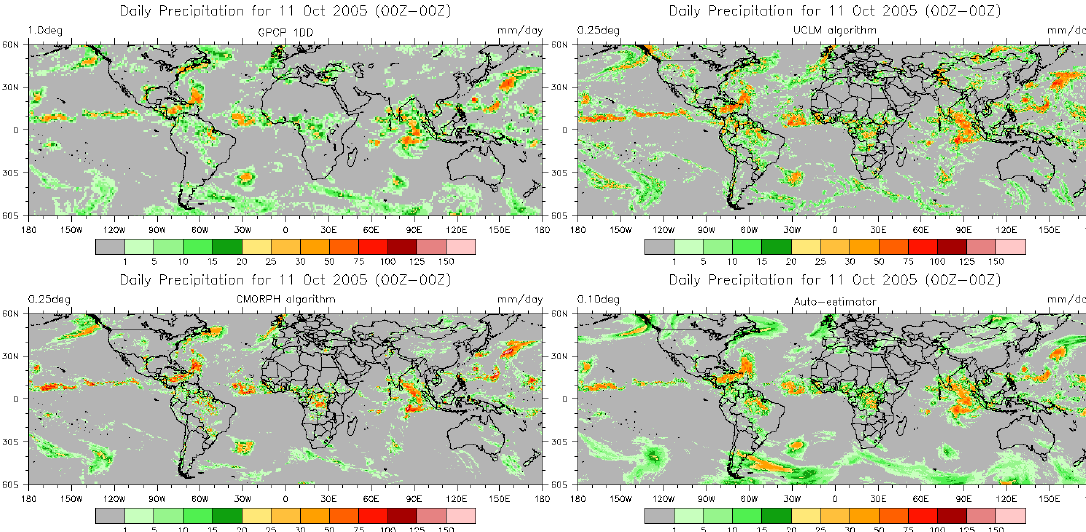
Figure 3. Comparison of daily precipitation estimates for 11 October 2005: GPCP 1DD gauge/multi satellite product and UCLM, CMOPH, and AUTO-ESTIMATOR algorithms.